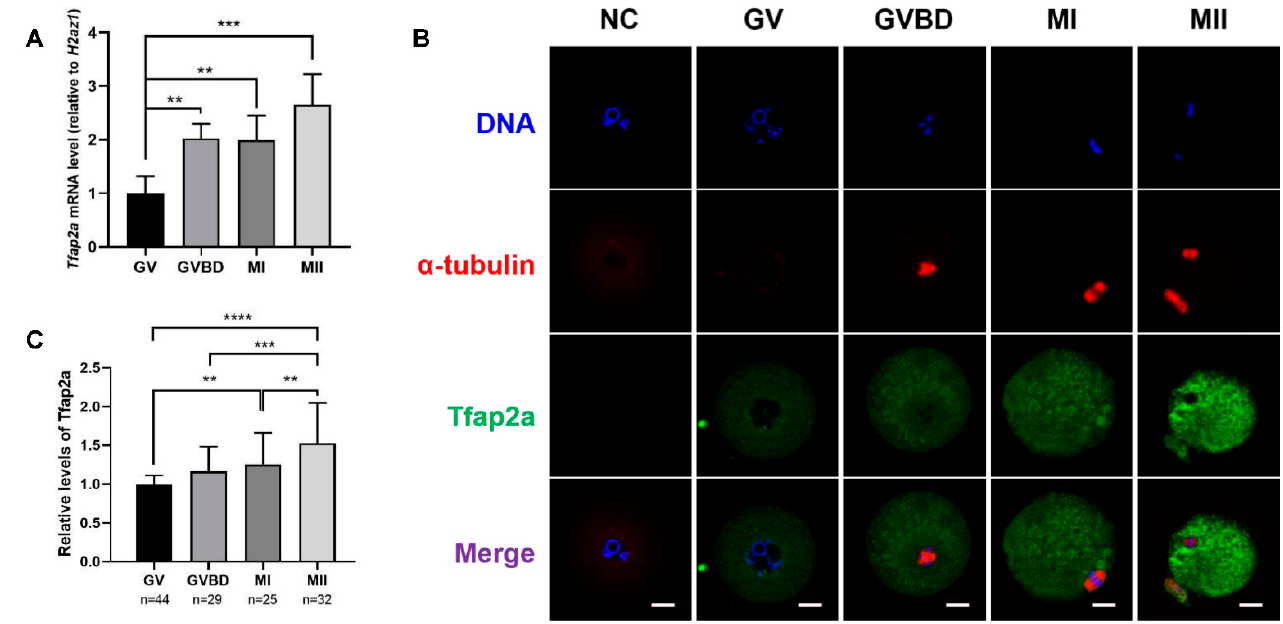
Figure 2. The levels and subcellular localizations of Tfap2a at different stages during mouse oocyte maturation. ( A ) The levels of Tfap2a mRNA at different stages based on qRT-PCR analysis. A total of 10 oocytes were collected after culturing for 0, 3, 8, or 14 h, corresponding to GV, GVBD, MI, and MII stages in each repeat, respectively. The levels of mRNA expression were normalized to H2az1 , and each bar represents the mean ± SEM ( n = 4). ** p < 0.01, *** p < 0.001. ( B ) The subcellular localizations of Tfap2a at different stages based on immunofluorescence. α -tubulin (red), DNA (blue), Tfap2a (green). NC: negative control; scale bar = 20 µm. ( C ) Relative fluorescence intensity of Tfap2a at different stages. Data are represented as the mean ± SEM of three independent experiments. ** p